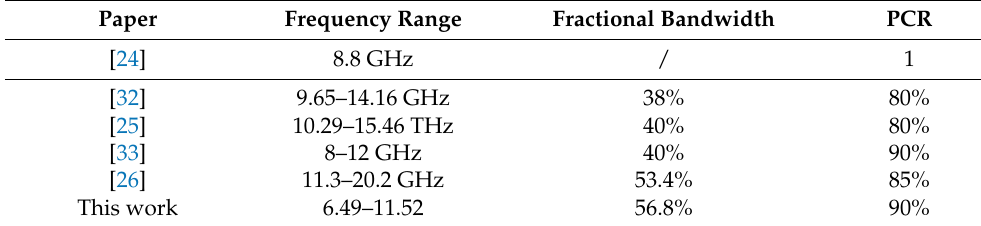
Figure 7. PCR with ( a ) a different incident angle; ( b ) a different polarization angle. Table 1. Performance comparison with previous works.